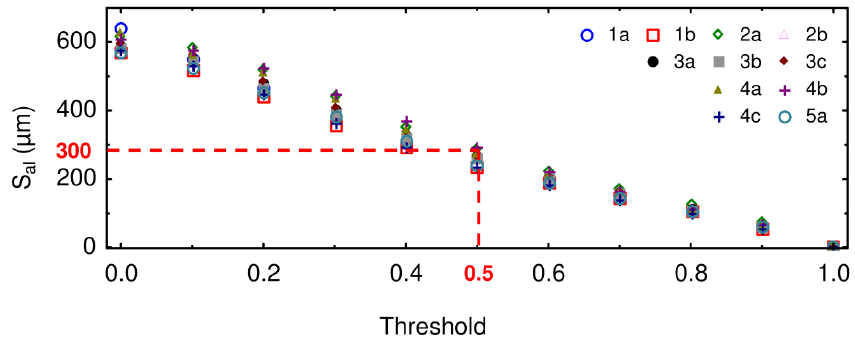
Figure 7. Autocorrelation length S al as a function of the threshold.